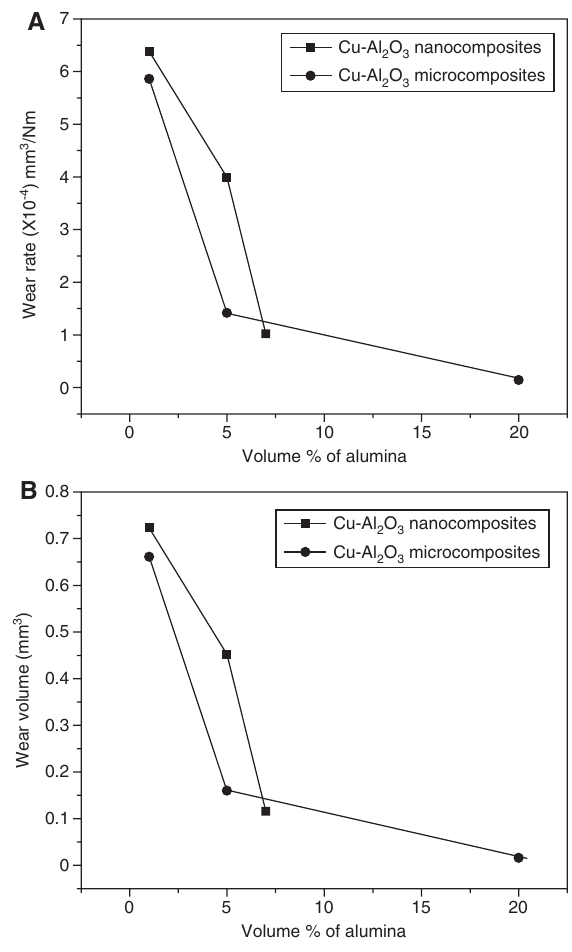
Figure 7: (A) Wear rate vs. volume% of alumina. (B) Wear volume vs. volume% of alumina of the micro- and nanocomposites.